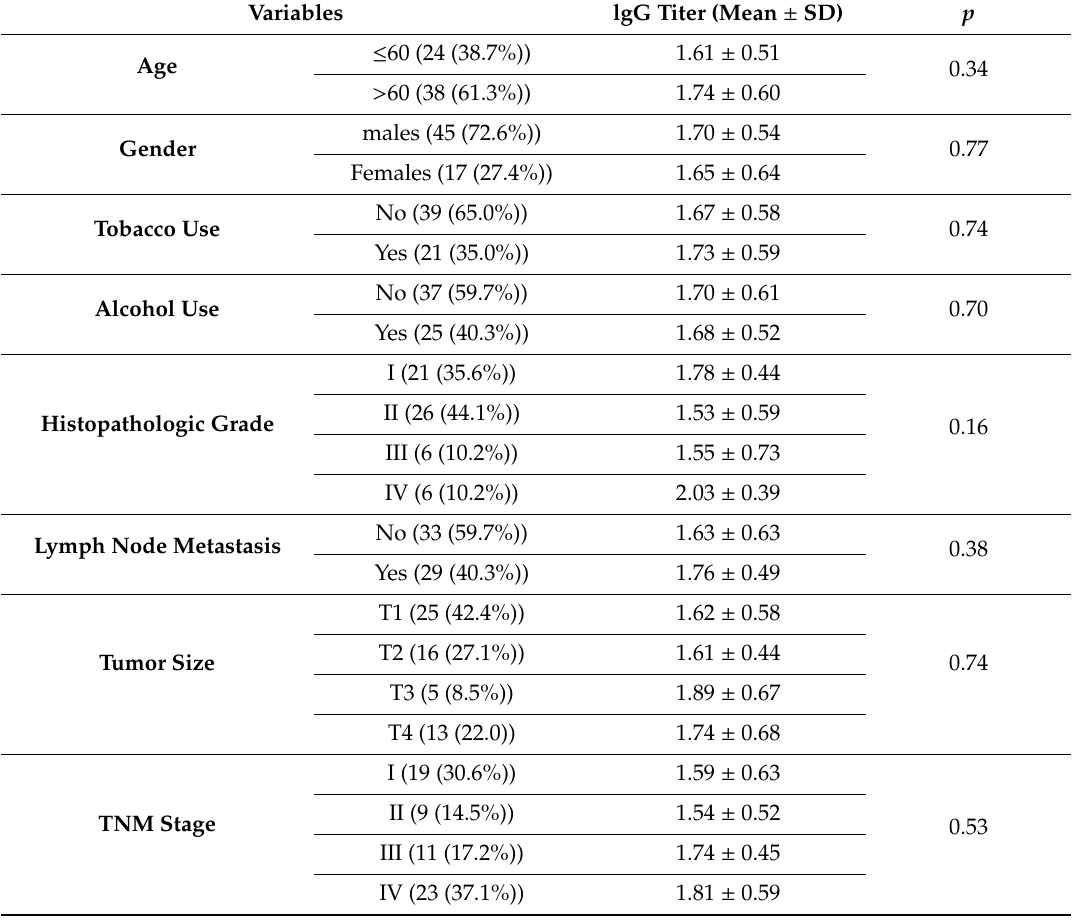
Table 1. Association between serum IgG antibodies against P. gingivalis and the clinicopathological features of OSCC.